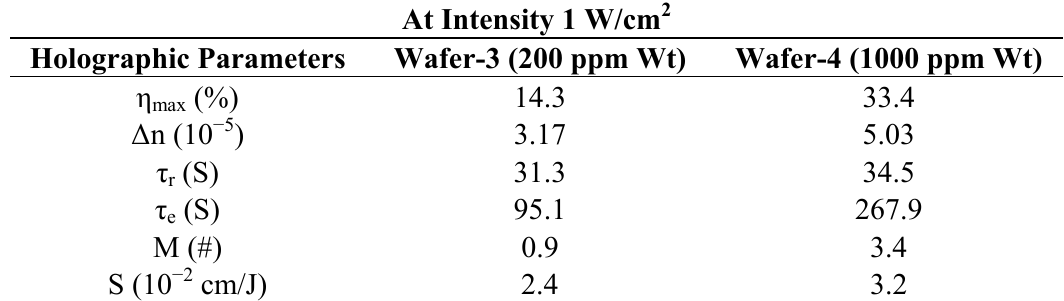
Table 3. Variation in photorefractive properties of the Mg, Fe co-doped near-SLT wafers under different Fe